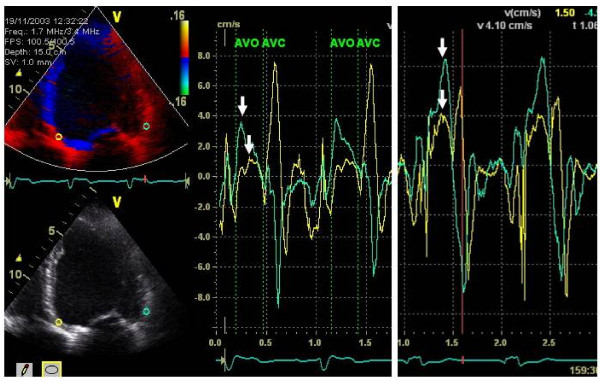
Tissue Doppler Imaging curves with systolic maximal velocity (SMV) preoperatively (left) and after implantation of CRT device (right), at best VV-interval (sequential pacing LV lead 40 ms before RV lead in this patient), showing improved systolic function, i.e. higher velocity. Signs of less dyssynchrony (arrows) are also seen.